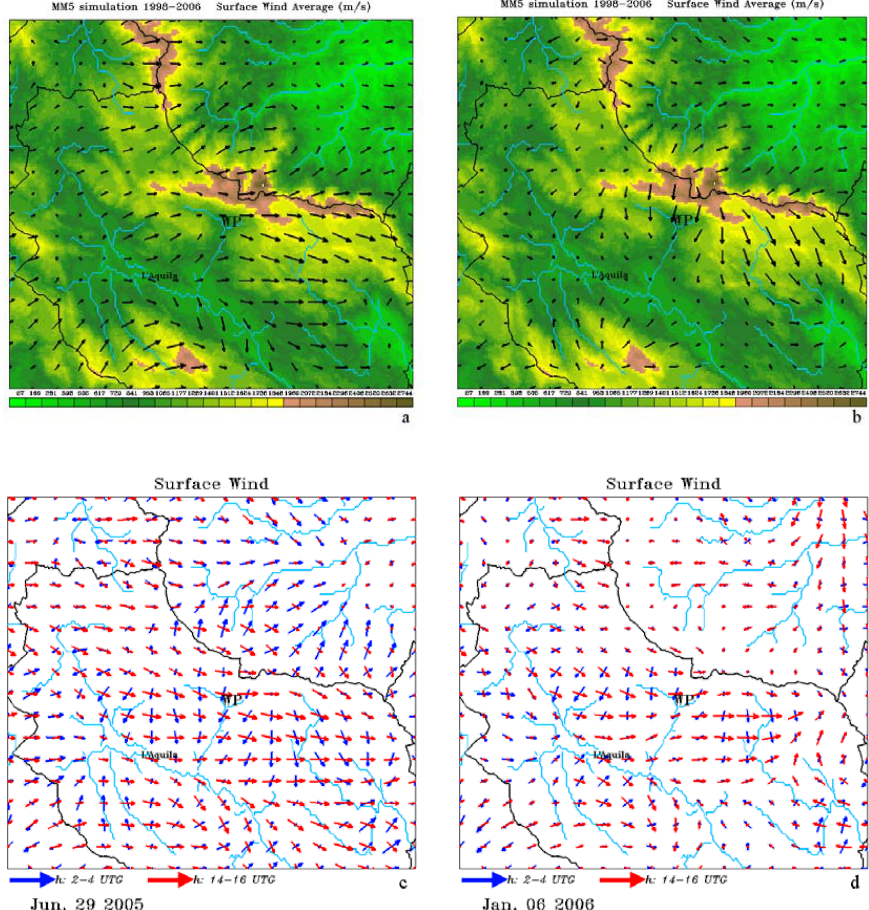
Fig. 3. Analysis of surface winds at the Assergi area carried out using long MM5 time series (years 1998-2005). Panel (a) is relative to summertime analysis, panel (b) to wintertime analysis. Wind arrows are shown at each MM5 grid point, and grid resolution is 3km. The wind profiler location is denoted with WP. Altitudes range from 600 to 2800m. Panels (c) and (d) show the daily wind rotation for two clear-sky situations, panel (c) for a summer case and panel (d) for a winter case. Blue arrows represent the average wind direction and intensity in the interval between 02:00–04:00 UTC, red arrows in the interval between 14:00–16:00 UTC.